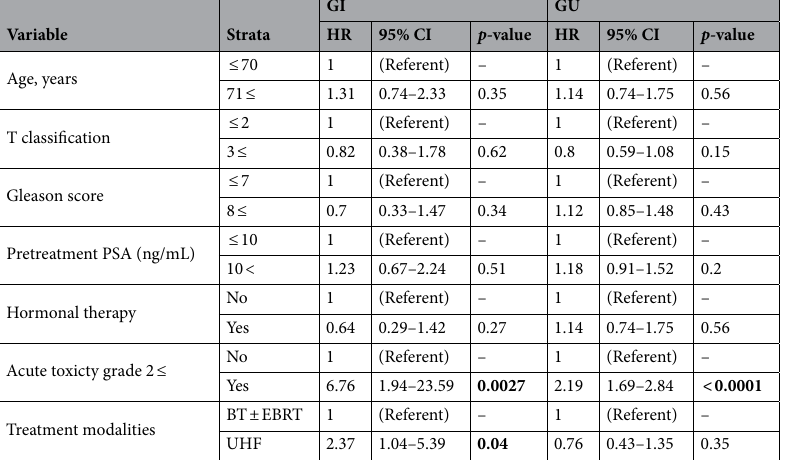
Subgroup (Accumulated incidence at 5-years) (PT